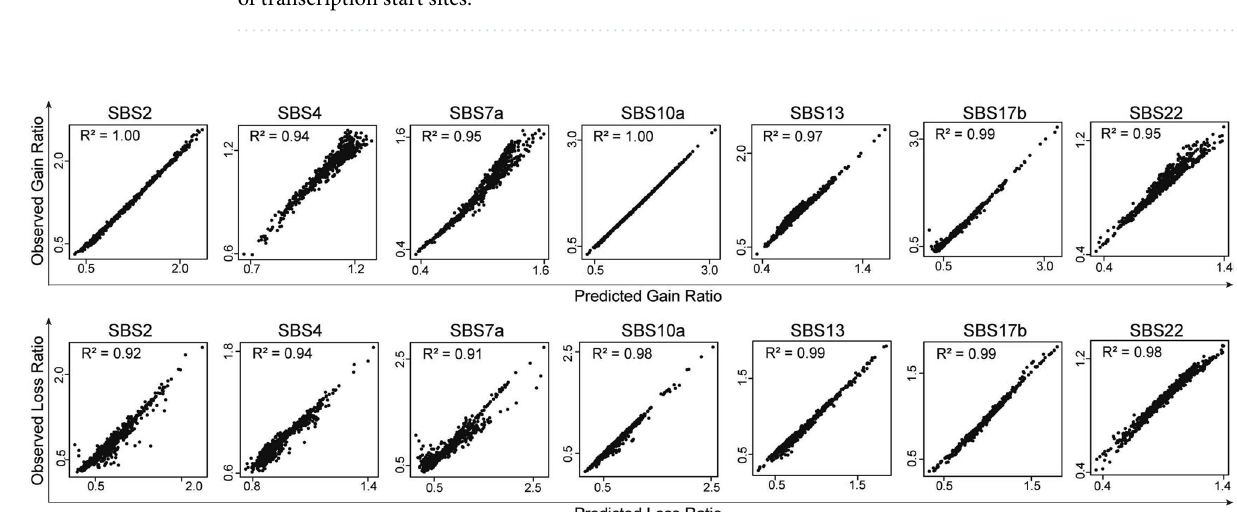
Table 1. Summary of tumors dominated by particular mutational signatures, selected for analysis of mutational signatures in proximal promoters. Table S1 provides details. a Regions from 2000 bp 5 ′ to 2000 bp 3 ′ of transcription start sites.